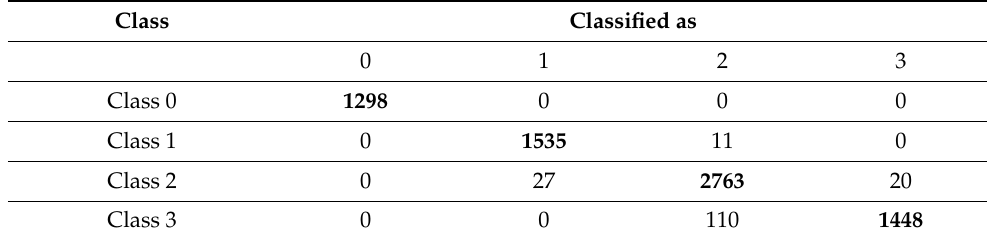
Table 8. The classification confusion matrix of the high-resolution frames on the test